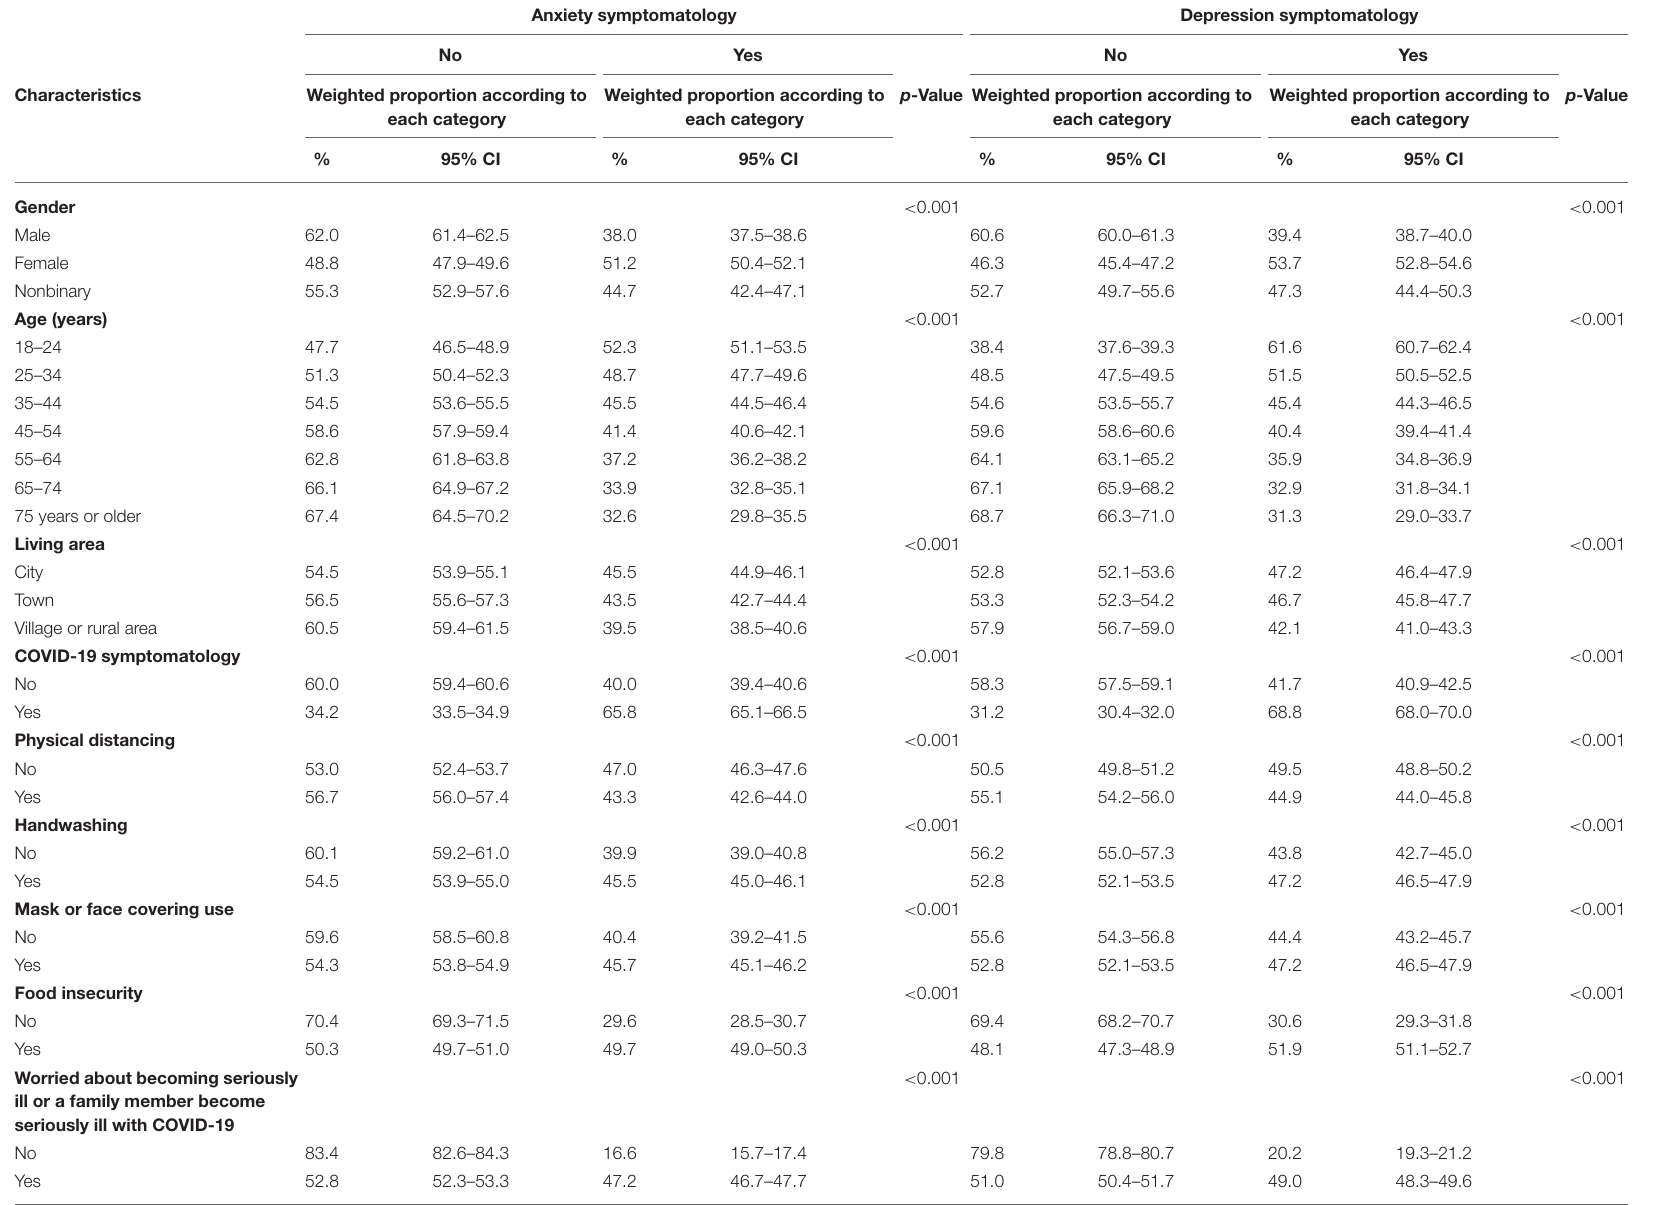
TABLE 2 | Bivariate analysis of the study sample characteristics according to anxiety or depression ( n = 1,338,320; N =